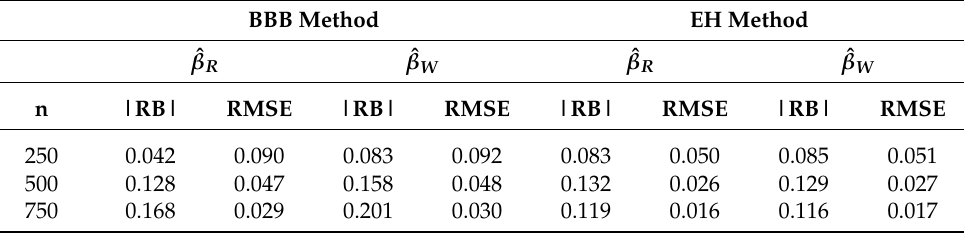
Figure 2. Boxplot for AV, JK and BS variances of ˆ β W 1 and ˆ β W 2 in SRSS in the BBB and EH models. For all randomization methods and in both models, regression and ratio, we can see (Table 3) how the values obtained from the relative bias and the relative mean squared error are small. Focusing on the RMSE, we observe that the value decreases as the sample size increases, as we expected, and we obtain a slightly better behavior of the ratio model compared to the regression model. Table 3. Absolute relative bias and relative mean squared error in percent for ˆ β R and ˆ β W in SRS for the BBB and EH